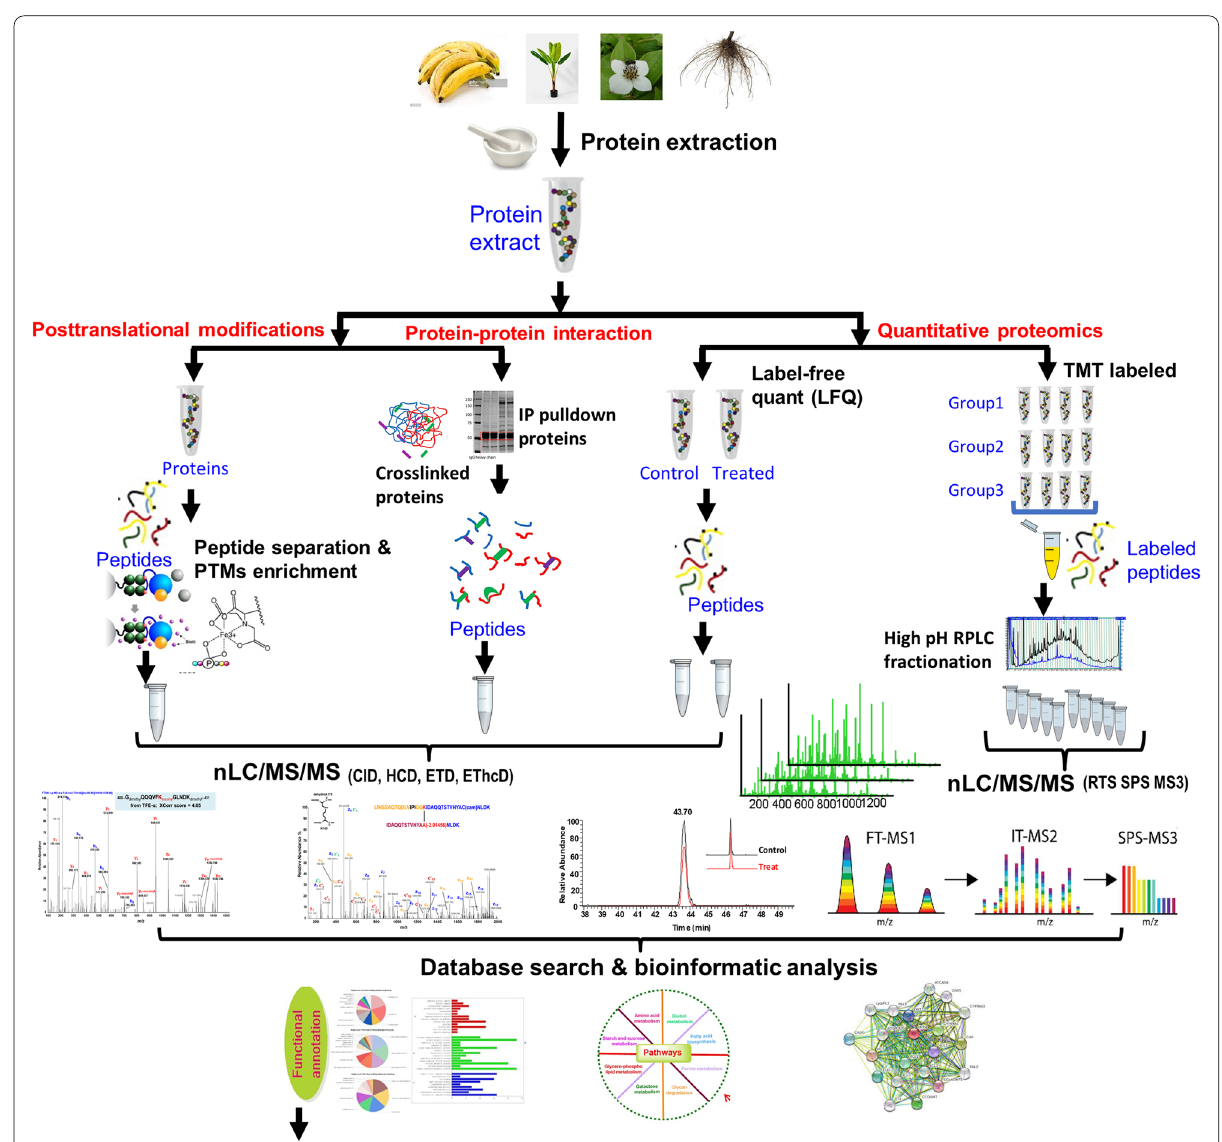
Fig. 2 Schematic diagram represents general plant proteomics workflows. Proteins extracted from plant materials are fractionated using either gel-based or gel-free techniques. Three major types of proteomics analysis for identification and quantitation of posttranslational modifications, protein-protein interaction and quantitative proteomics were presented. The MS raw data generated from each workflow using different mass spectrometric techniques are carried out by database search, statistical analysis and bioinformatics analysis. Finally, the outcomes are to be further validated for either generating biological hypothesis or validation of initial mechanistic